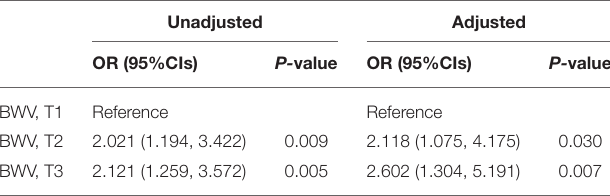
TABLE 2 | Binary logistic regression of BWV for rapid progression of CAC. Unadjusted